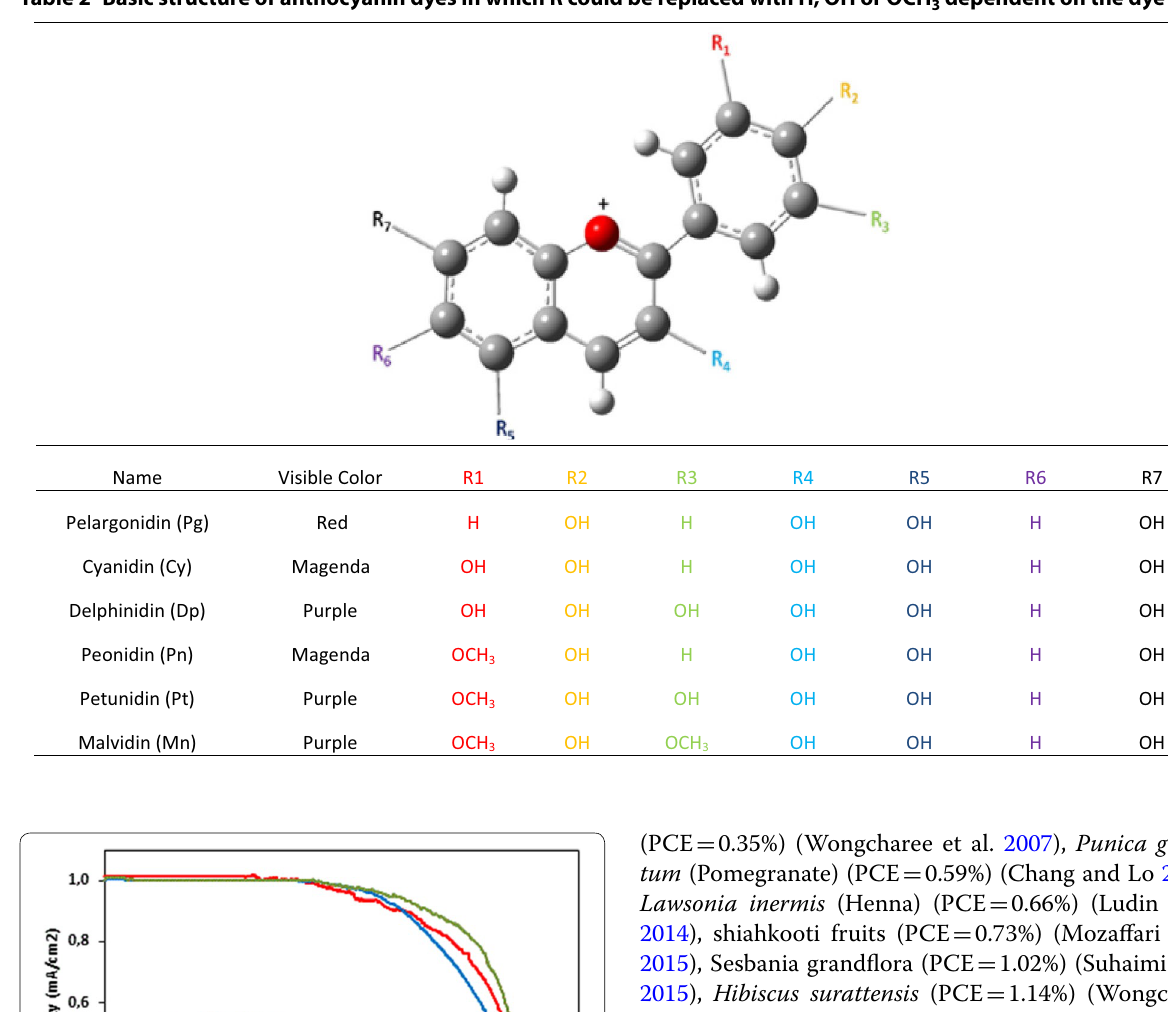
Table 2 Basic structure of anthocyanin dyes in which R could be replaced with H, OH or OCH